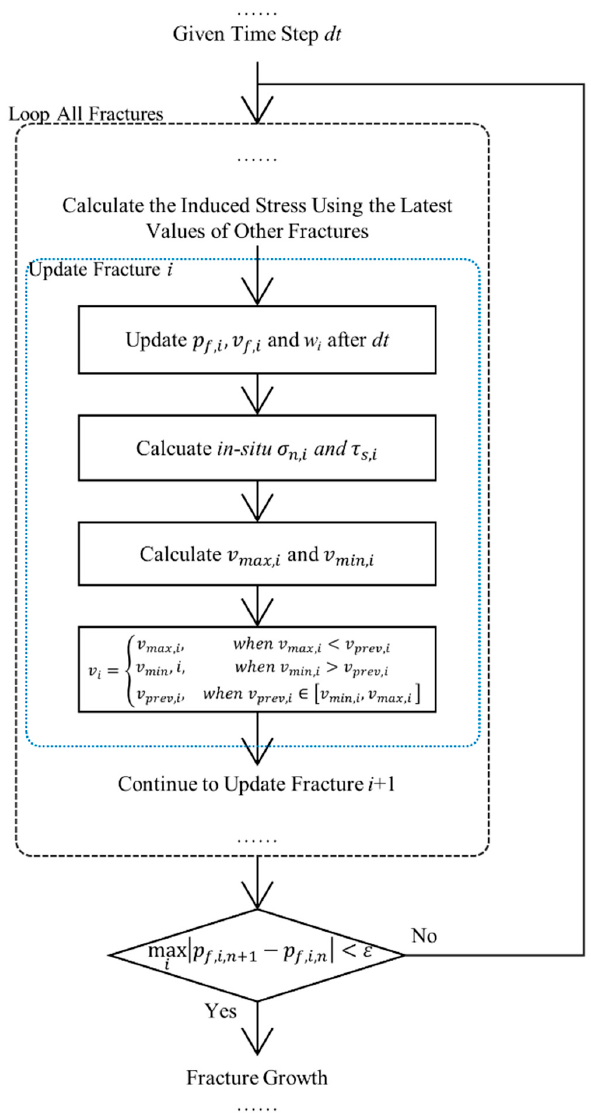
Figure 1. The flowchart for updating the shear displacement discontinuity of each fracture element after the given time step dt during the fluid-rock coupling iteration. Here, p f and v f refer to fluid pressure and fluid volume, respectively, v max and v min are the maximum and the minimum values of shear displacement discontinuities, respectively, and v prev is the shear displacement discontinuity of the fracture element in the last step.